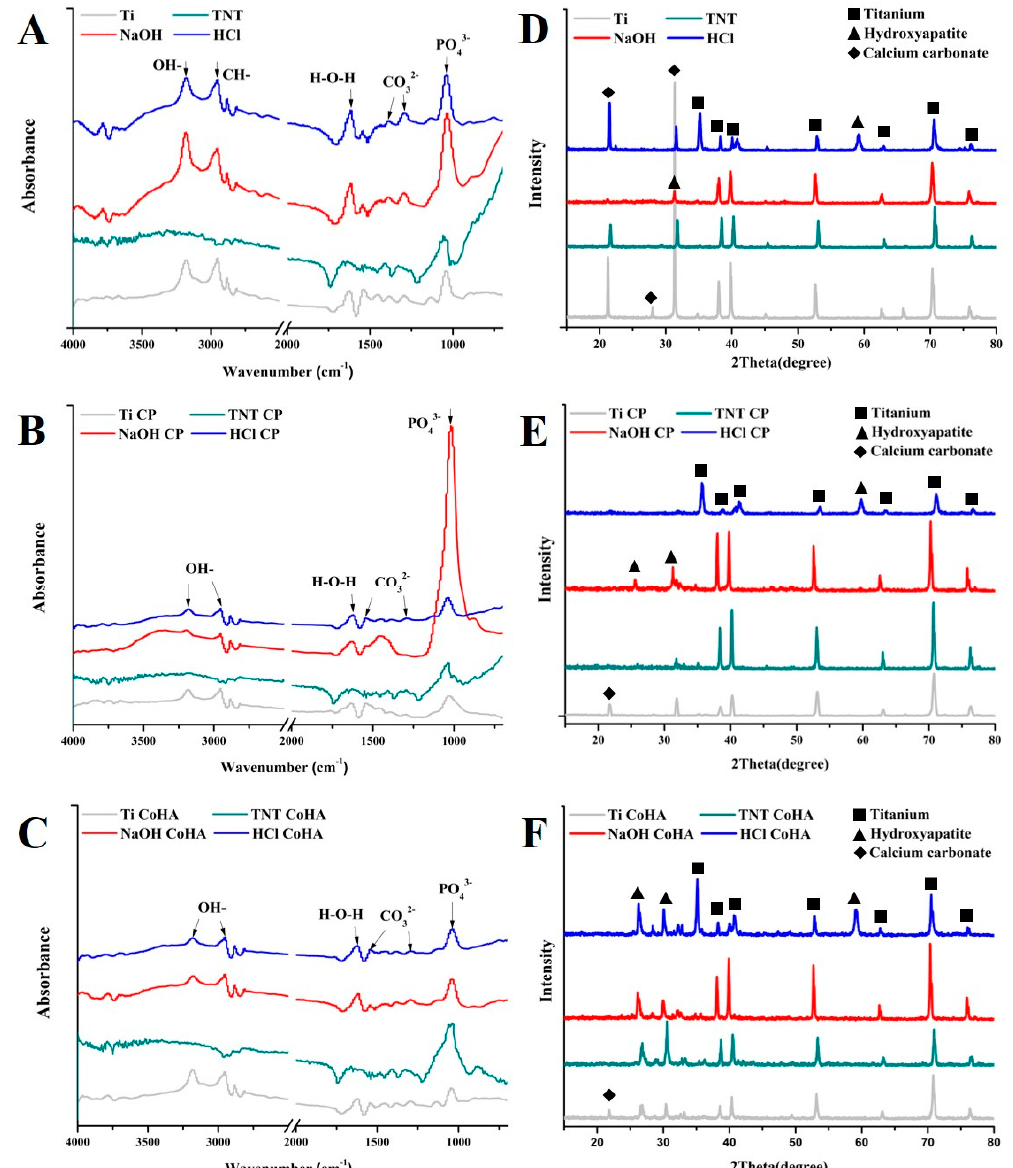
Figure 8. The characteristics of the LAB-treated samples after soaking in SBF for seven days. ( A – C ) FTIR spectra obtained from original, LAB CaP solution, and LAB CoHA solution. ( D – F ) XRD patterns of the original, LAB CaP solution, and LAB CoHA solution.